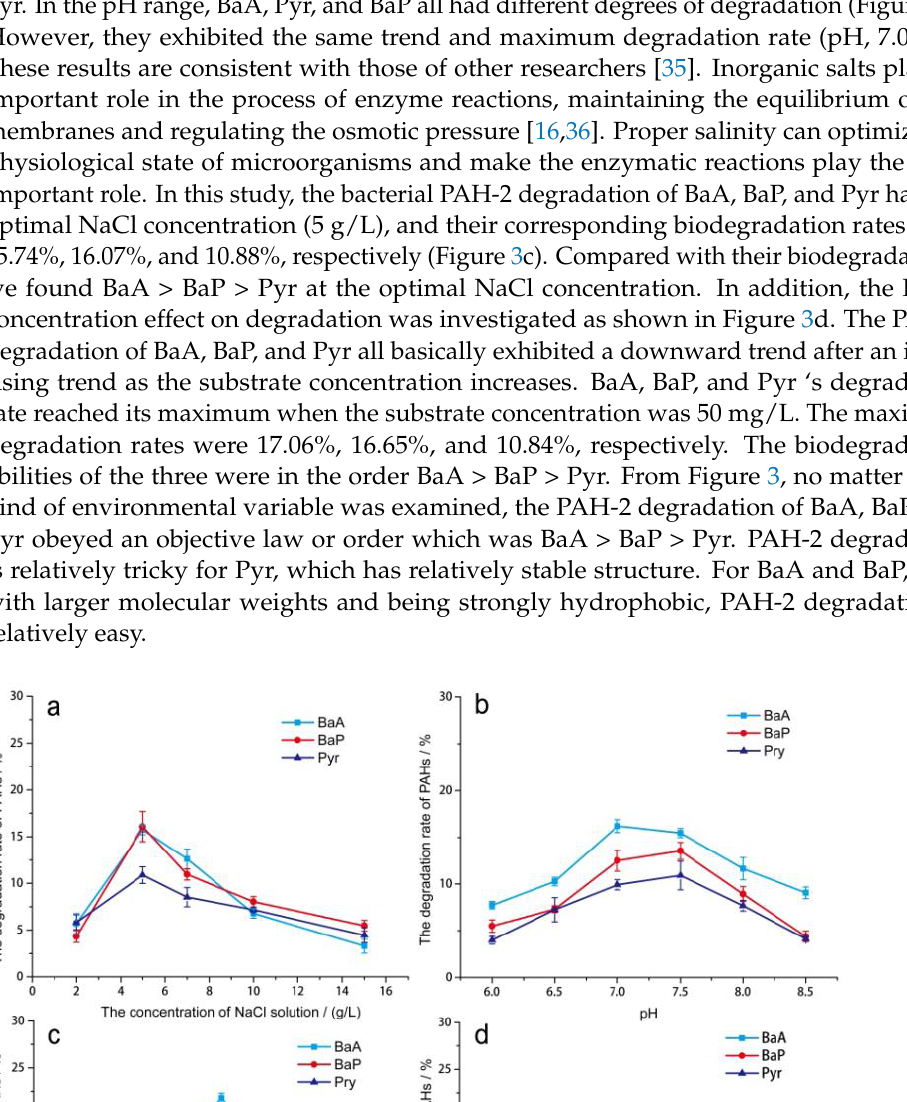
Figure 4. PAH-2 degradation rates of ( a ) BaA, ( b ) BaP, and ( c ) Pyr and the bacteria number during the degradation process changes with time and the black inserts (10, 20, 30 d) represent the bacte- rial hydrophobicity during degradation. Each experiment was repeated three times to ensure re- peatability and accuracy of the data.